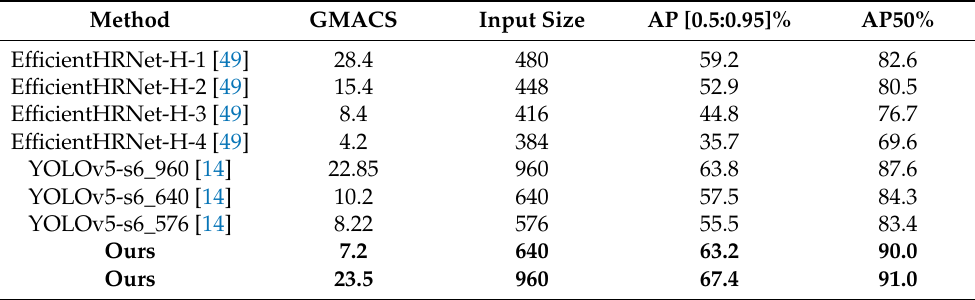
Table 3. Comparison of Network Complexity and Average Accuracy between Our Model and Other Lightweight Models on COCO 2017.